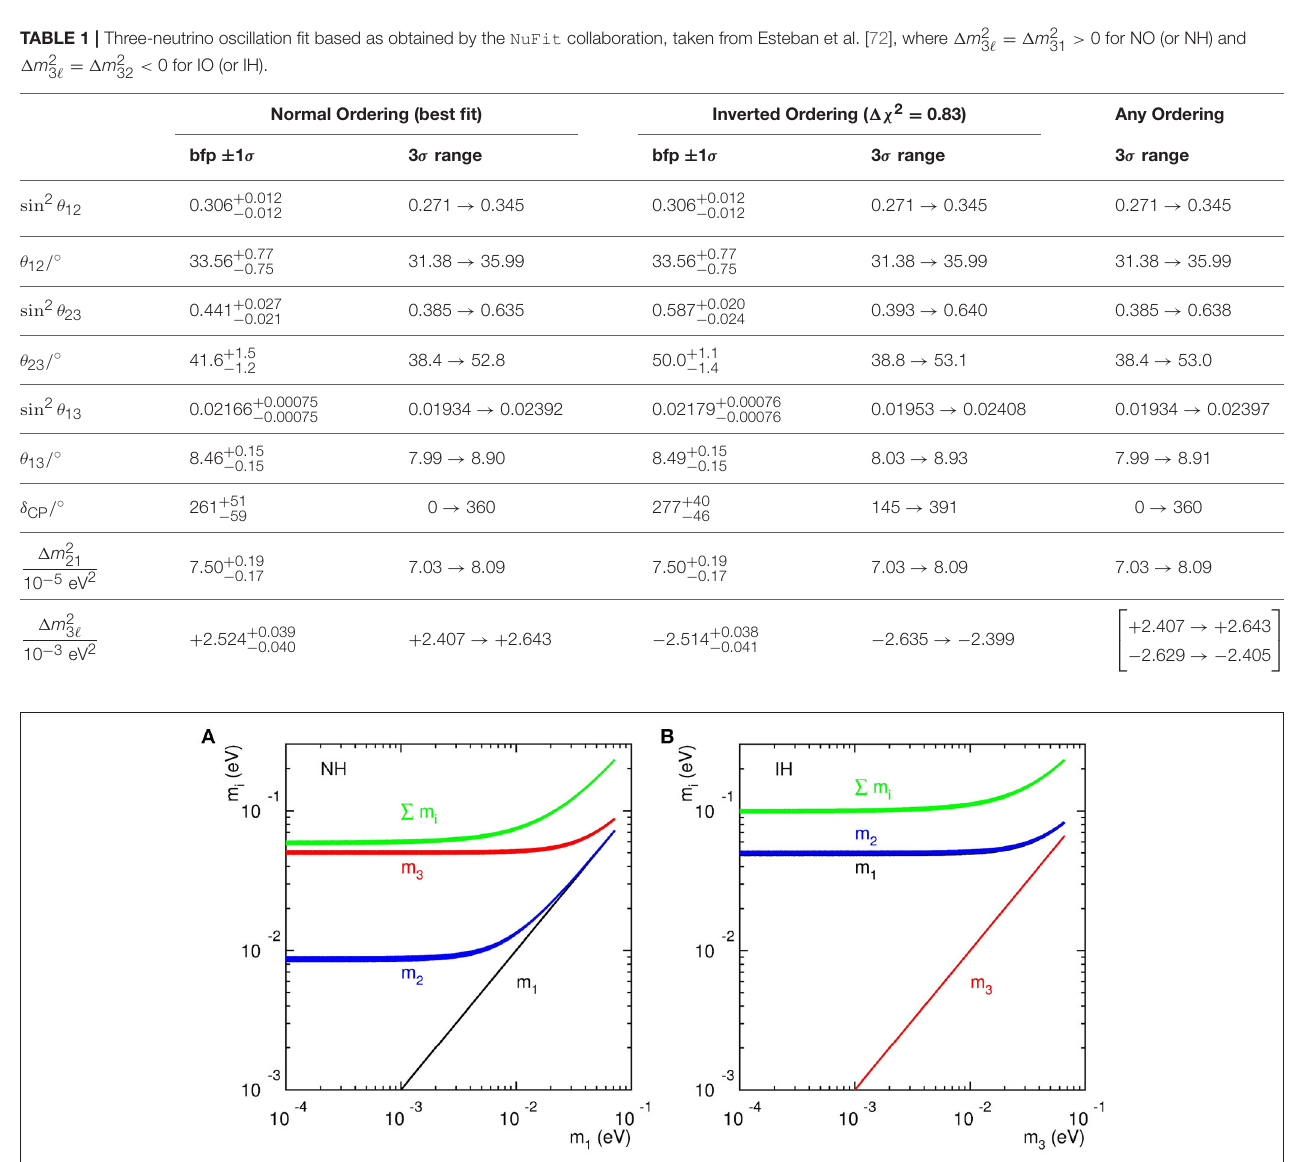
1 m 2 31 > 0 for NO (or NH) and =